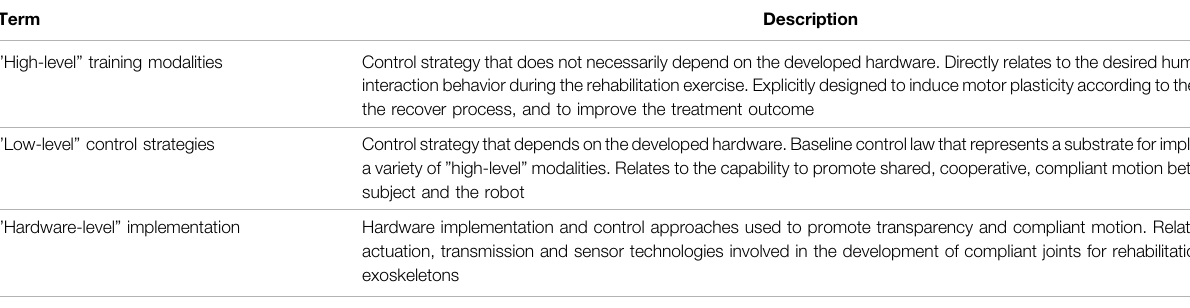
TABLE 1 | Presented classi fi cation of control methods for patient-cooperative compliant robotics for upper-limb rehabilitation. Term